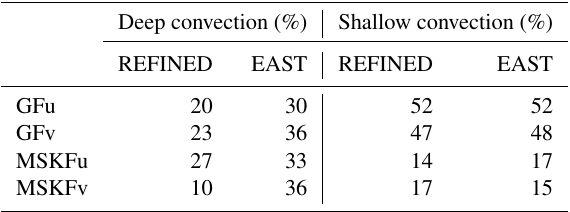
Table 2. Area-averaged incidence of deep and shallow convection. The REFINED and EAST areas are shown in Fig.